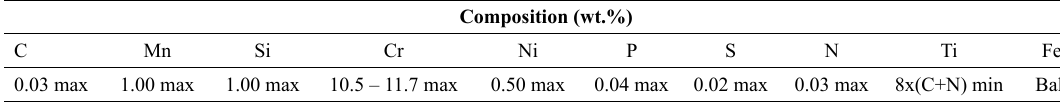
Table 1. Nominal chemical composition of the AISI 409 stainless steel.